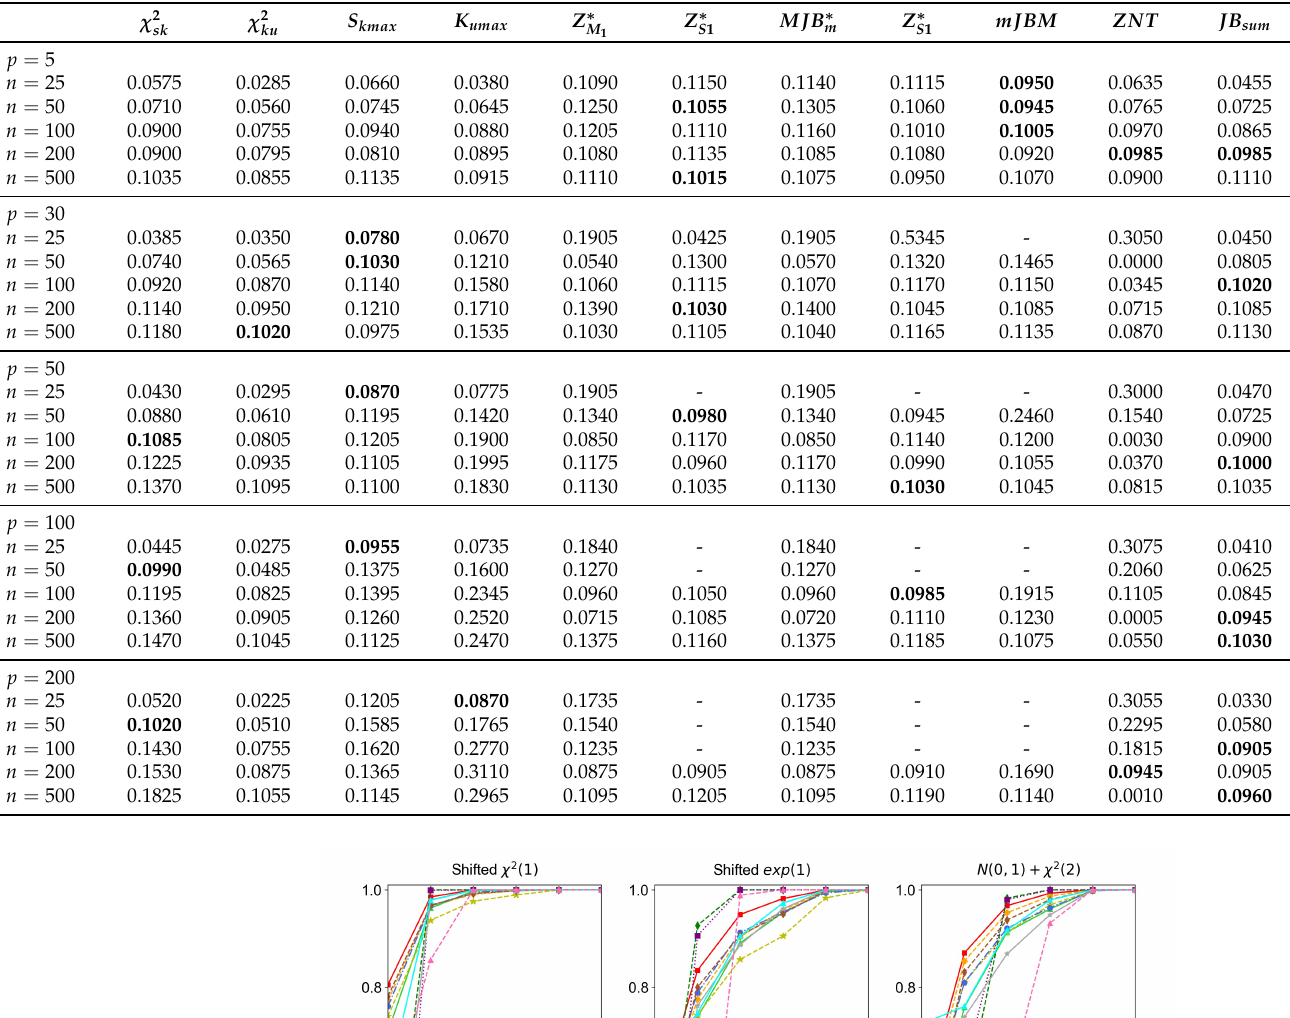
Table 3. Empirical power of PC-type Jarque–Bera (JB) testing for normally distributed data for Case-I compared with other methods ( α = 0.1).